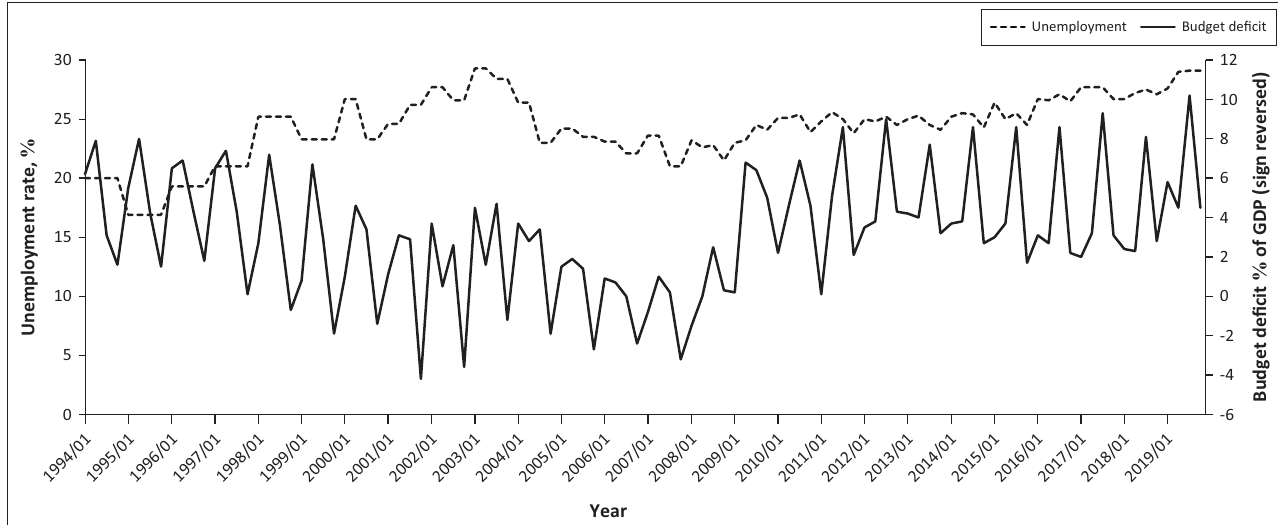
FIGURE 1: Unemployment and budget deficit in South Africa